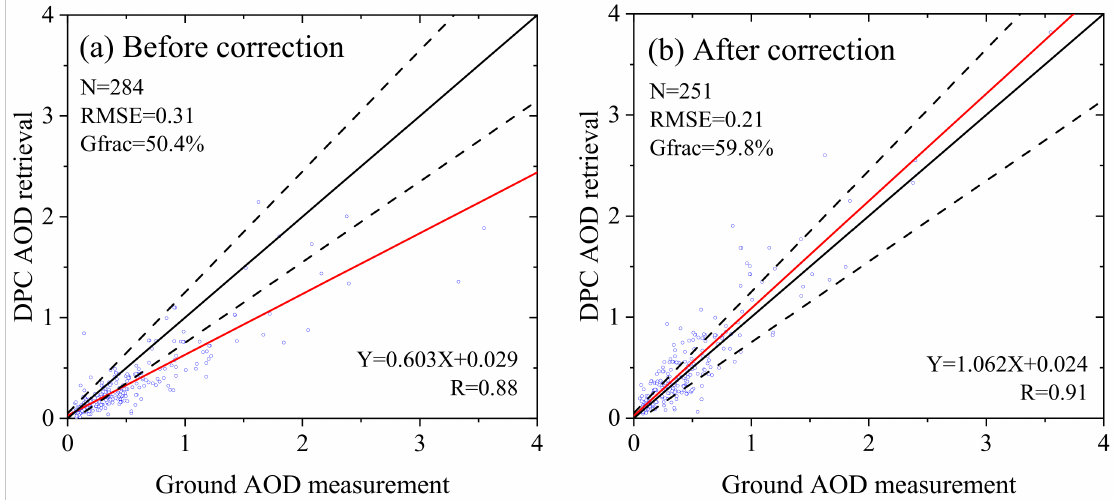
Figure 11. The comparison of AOD retrievals with the ground-based observations at 550nm by using ( a ) the original DPC data and ( b ) the radiometric corrected DPC data. Black solid, dashed lines and red lines are the 1:1 lines, EE envelope lines and fit lines,